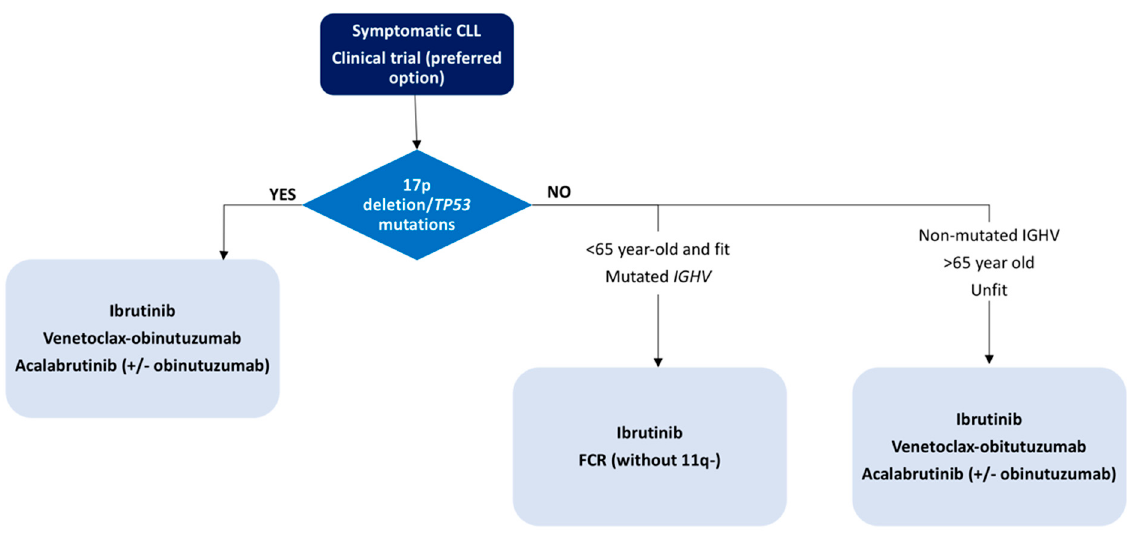
Figure 2. First-line treatment algorithm for CLL patients.